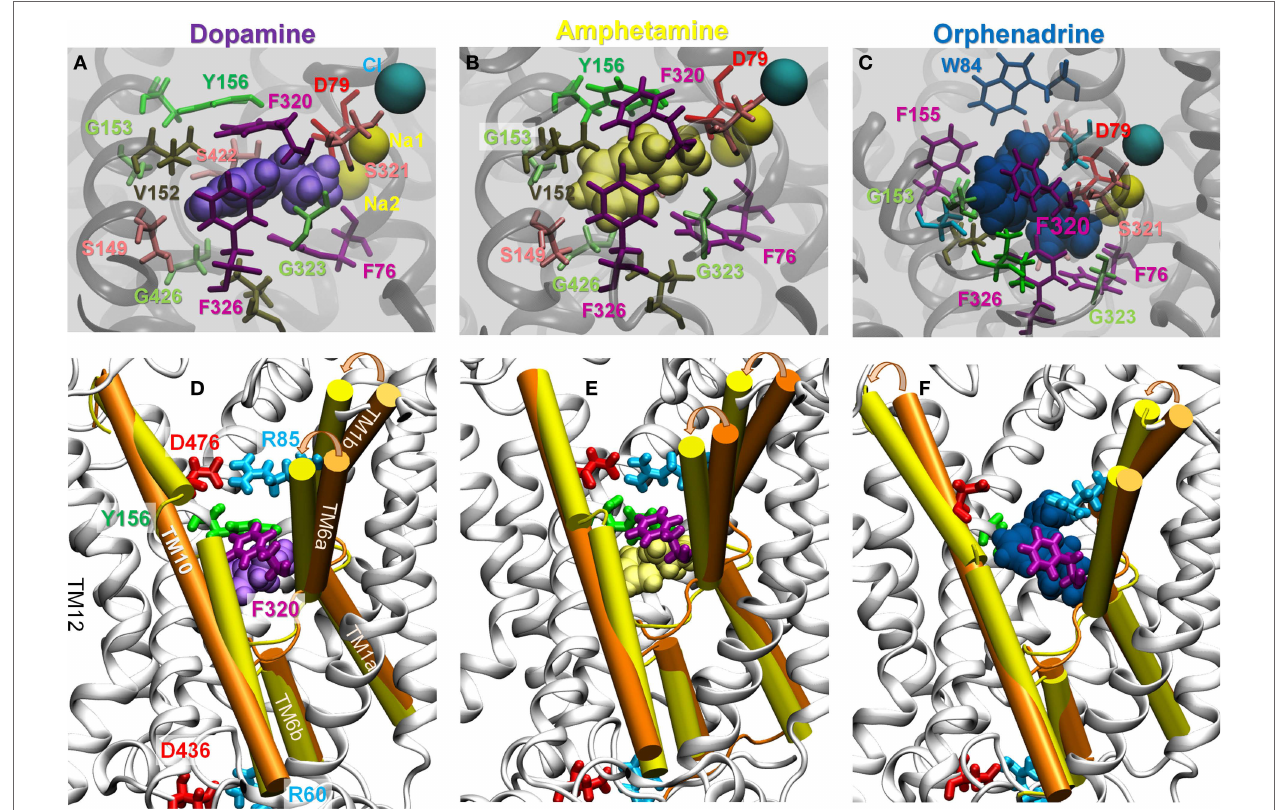
(a) DA, (B) AMPH, and (c) ORPH. Alignment of the initial OF o hDAT (orange) with the MD-relaxed hDAT (yellow) in the presence of (D) DA; (e) AMPH; and (F) ORPH. For clarity, only TM1, TM6, and TM10 helices are highlighted in cartoon and MD-relaxed structures are shown in white ribbon. Results are taken from the last 100 ns MD simulations in each